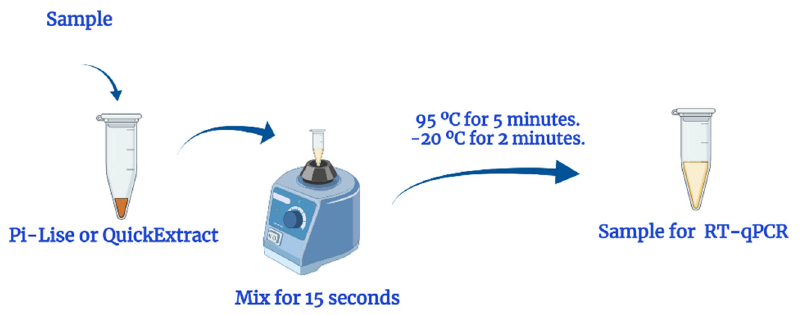
Figure 1. Scheme of rapid nucleic acid extraction.